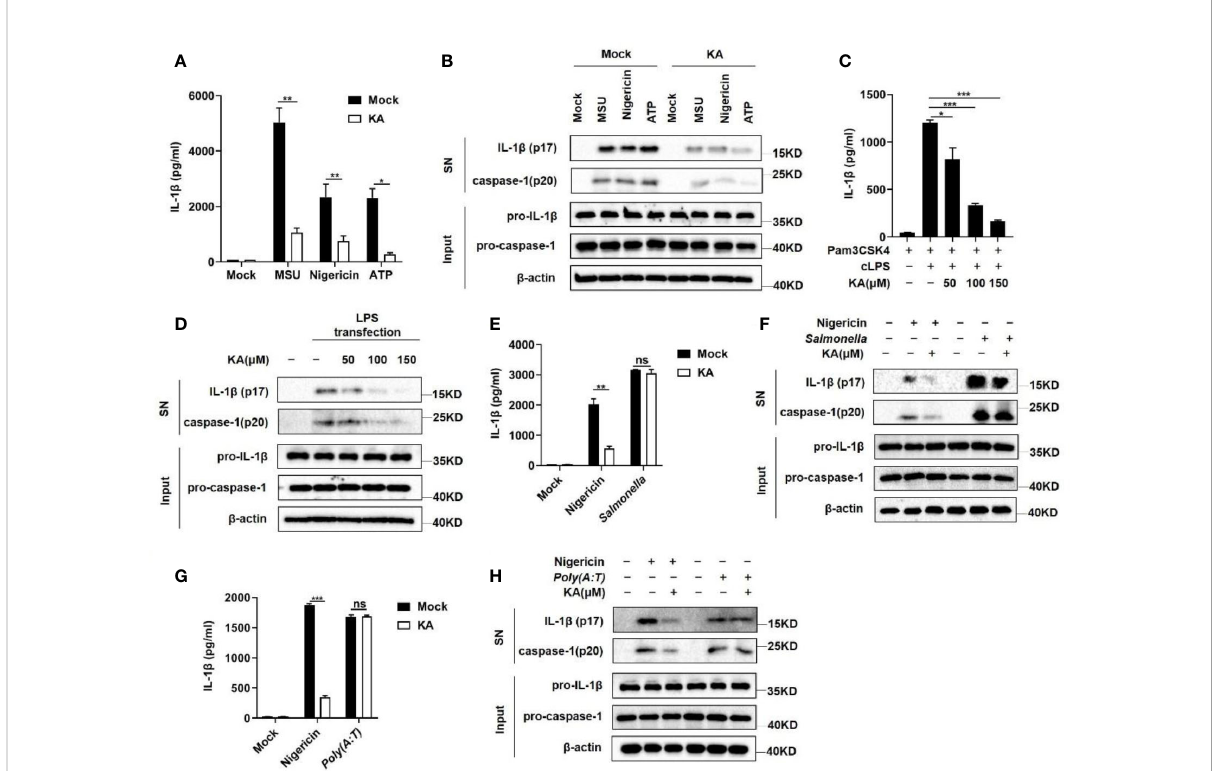
FIGURE 2 KA speci fi cally suppressed the NLRP3 in fl ammasome. (A, B) LPS-primed BMDMs were pretreated with or without KA (150 m M) for 2 hours and then stimulated with MSU, nigericin, or ATP. Mock denotes stimulation with PBS. ELISA of IL-1 b in the SN of BMDMs (A) and western blot analysis of IL-1 b and cleaved caspase-1 in the SN of BMDMs and pro-IL-1 b and pro-caspase-1 in the lysates (input) of BMDMs (B) . (C, D) Pam3CSK4-primed BMDMs were treated with KA for 2 h and then stimulated with cytoplasmic LPS by transfection for 16 h. ELISA of IL-1 b in the SN of BMDMs (C) and western blot analysis of IL-1 b and cleaved caspase-1 in the SN of BMDMs and pro-IL-1 b and pro-caspase-1 in the lysates (input) of BMDMs (D) . (E, F) LPS-primed BMDMs were treated with KA for 2 hours and then stimulated with nigericin for 30 minutes or subjected to Salmonella typhimurium infection for 4 hours. ELISA of IL-1 b in the SN of BMDMs. (E) Western blot analysis of IL-1 b and cleaved caspase-1 in the SN of BMDMs and pro-IL-1 b and pro-caspase-1 in the lysates (input) of BMDMs (F) . (G, H) LPS-primed BMDMs were treated with KA for 2 hours and then stimulated with nigericin for 30 minutes or subjected to poly(dA:dT) transfection for 4 hours. ELISA of IL-1 b in the SN of BMDMs (G) and western blot analysis of IL-1 b and cleaved caspase-1 in the SN of BMDMs and pro-IL-1 b and pro-caspase-1 in the lysates (input) of BMDMs (H) . Data are representative of three independent experiments and show as the mean ± SEM. Statistical signi fi cance was analysed by unpaired t test: *p < 0.05, **p < 0.01, ***p < 0.001; ns, no signi fi